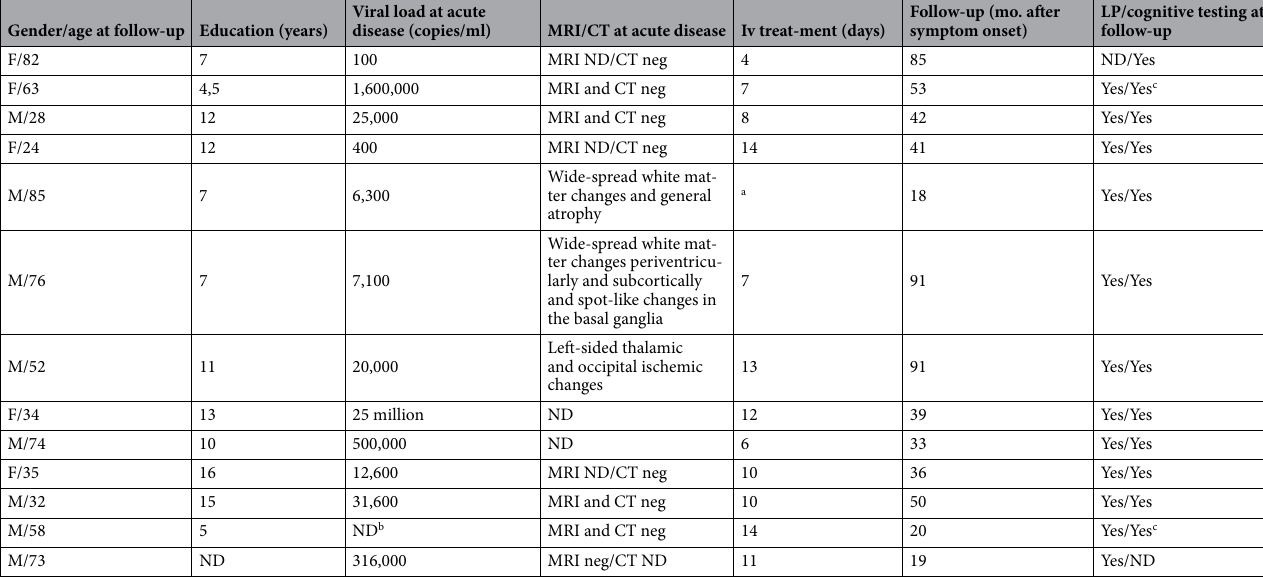
Table 1. Demographic data of 13 patients with previous encephalitis caused by reactivated varicella-zoster virus. CT computer tomography, Iv intravenous, ND not done, LP lumbar puncture, MRI magnetic